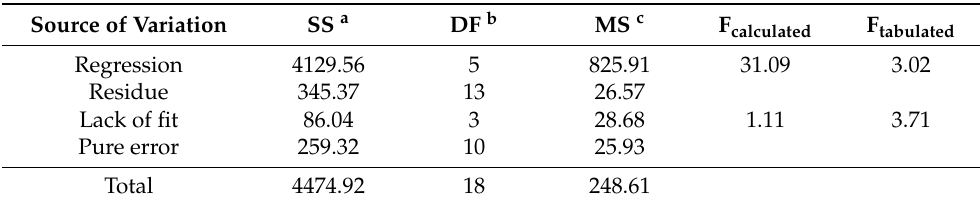
Table 3. Analysis of variance (ANOVA) for the experimental design of the esterification/ transesterification of SODD with isoamyl alcohol catalyzed by Eversa Transform 2.0.